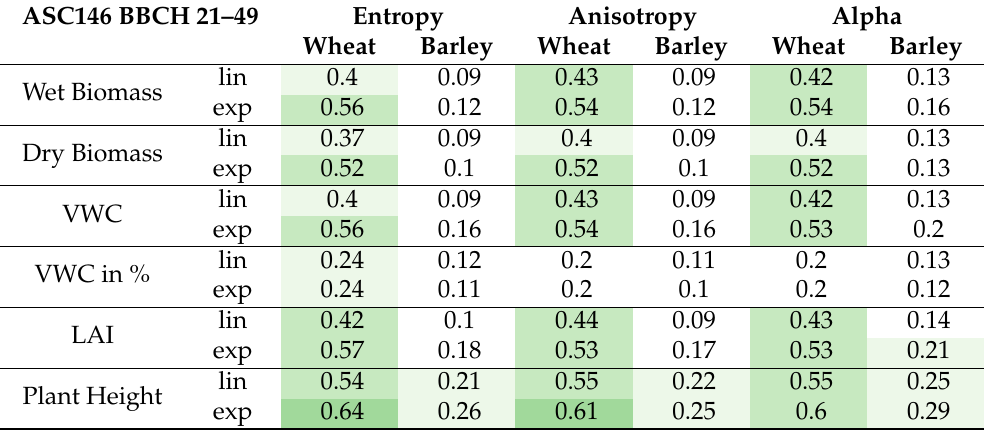
Table 4. R 2 values of the regression between crop and dual-polarimetric parameters per crop type for all fields in BBCH stages 21–49. The darker the shade of green, the higher the R 2 value.